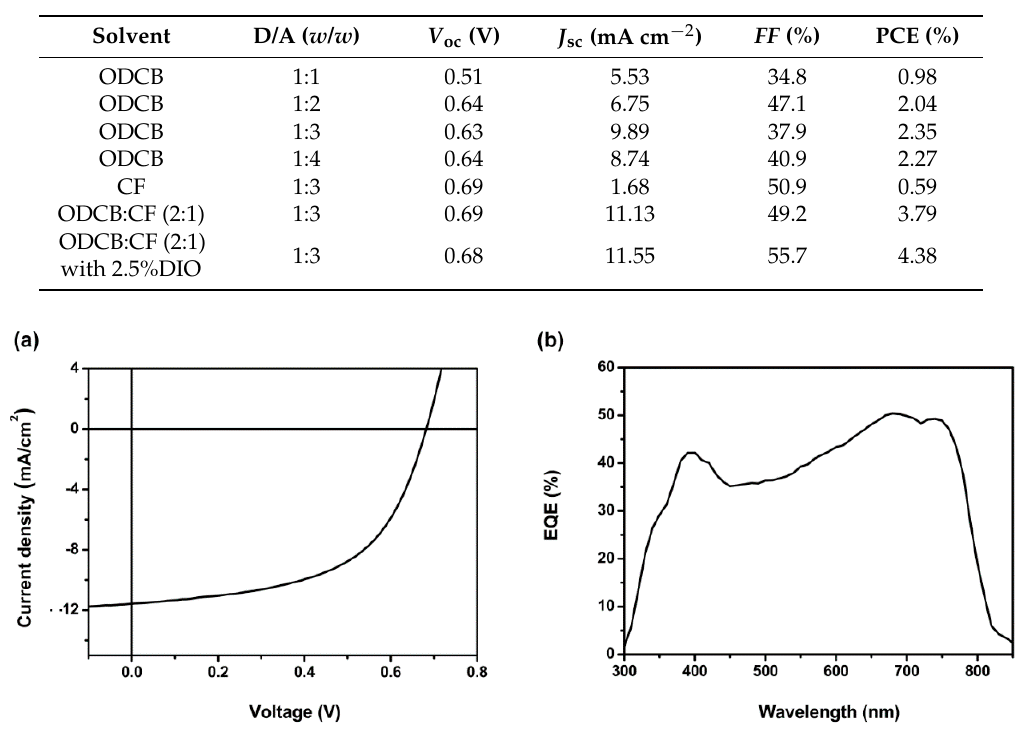
Table 1. Photovoltaic properties of the PSTDPP/PC 71 BM-based bulk heterojunction (BHJ) solar cells fabricated with different solvents.